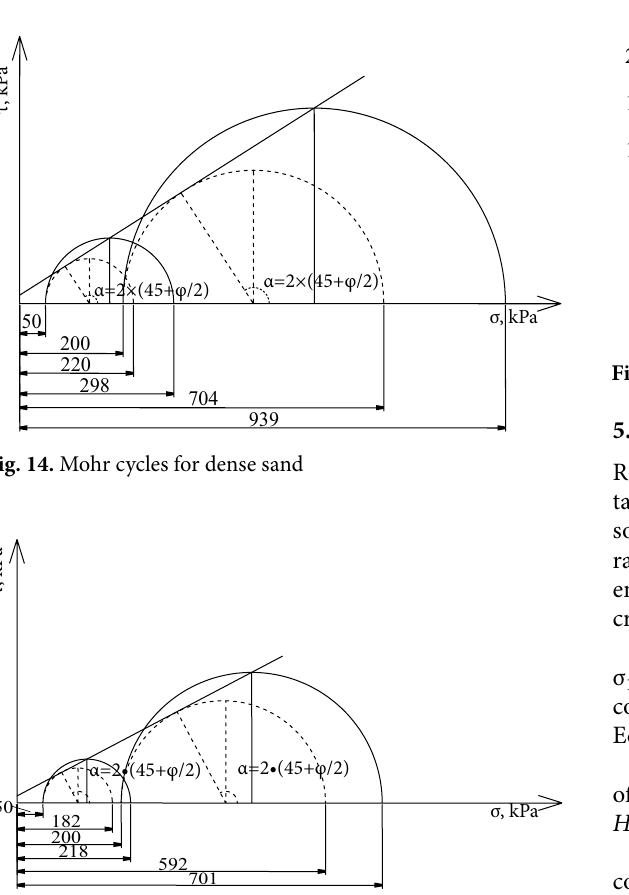
Fig. 15. Mohr cycles for loose sand